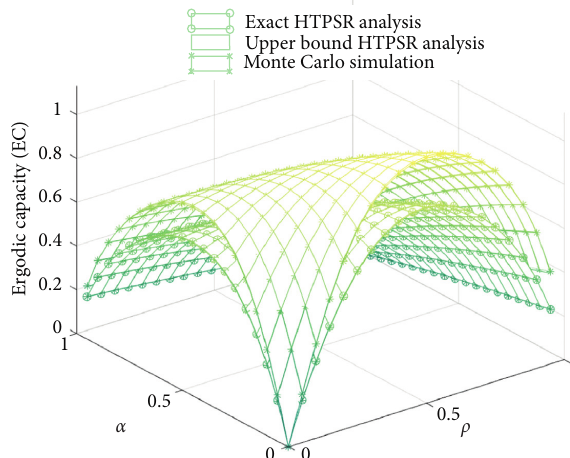
Figure 5: EC versus α and ρ for HTPSR protocol.